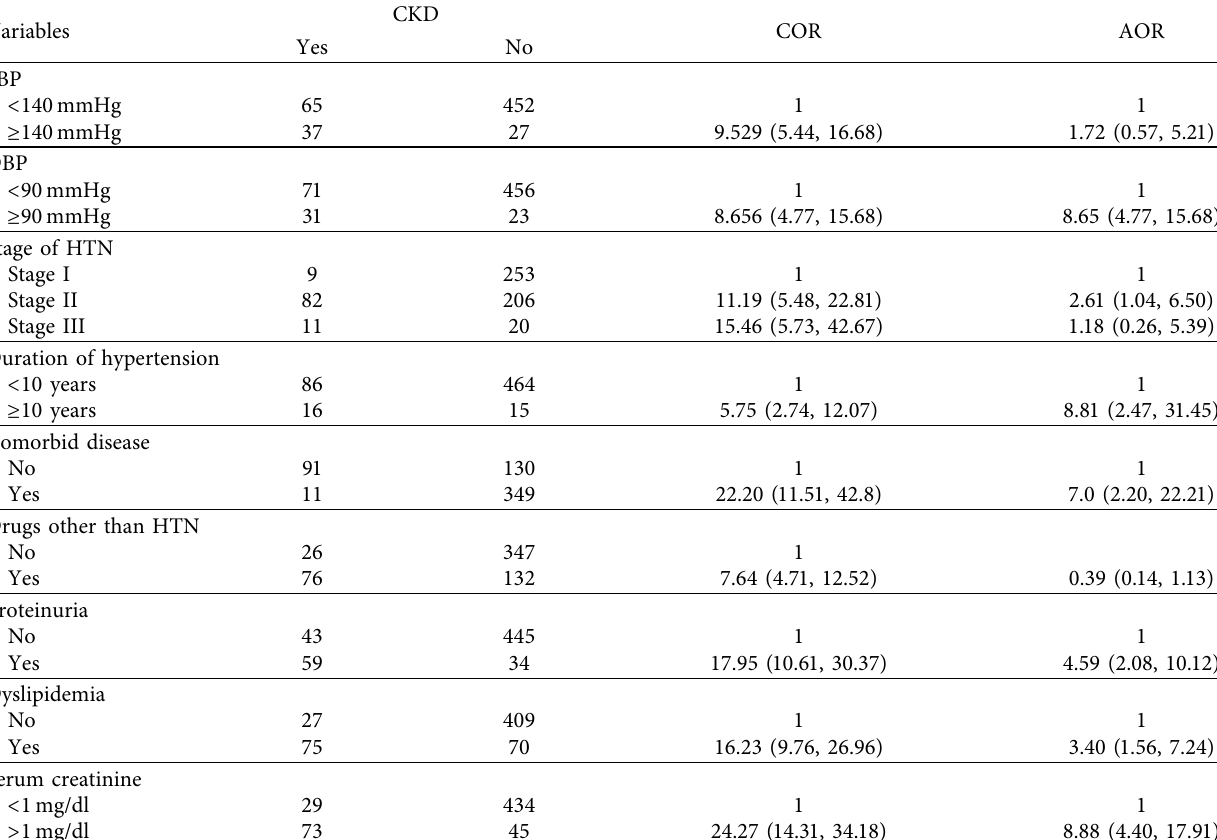
Table 5: Bivariate and multivariate analyses of hypertensive patients attending at the chronic follow-up clinic at Northwest Ethiopia referral